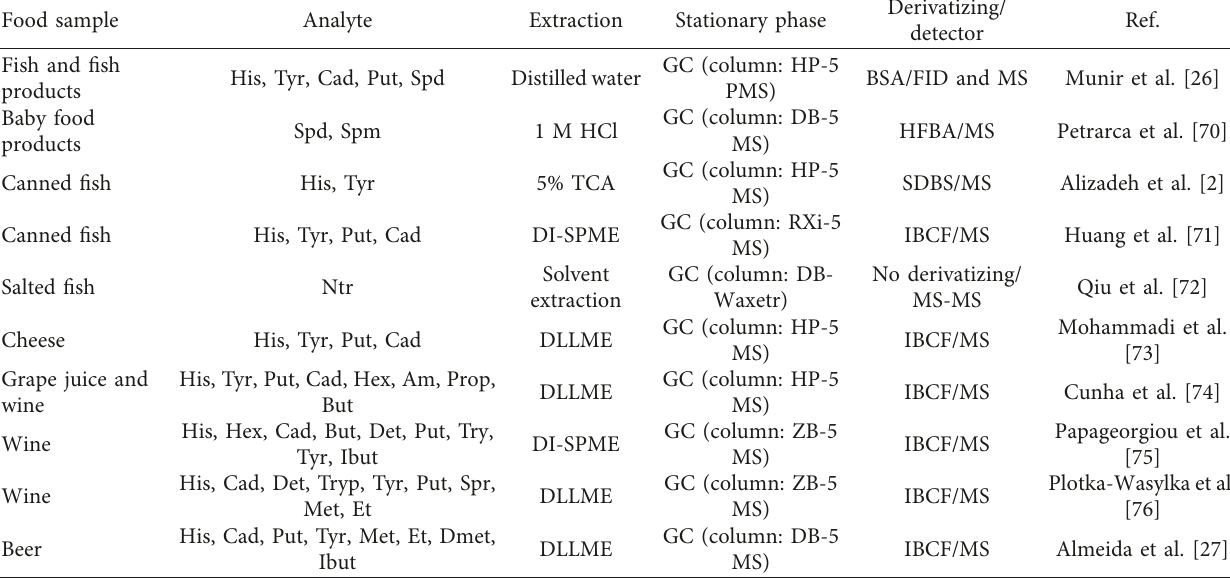
Table 4: Various studies based on GC techniques for biogenic amine detection in food and